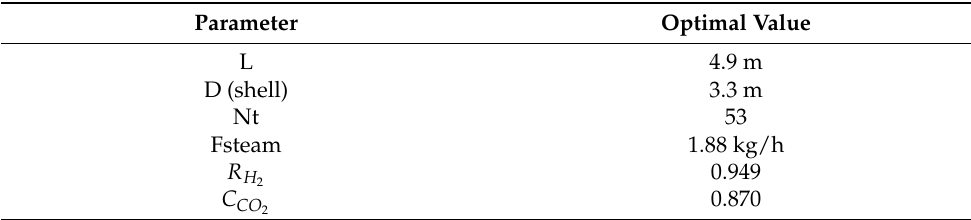
Table 2. Optimal membrane reactor design that produces the “best tradeoff” between hydrogen recovery and carbon capture according to the defined objective in Equation (17).